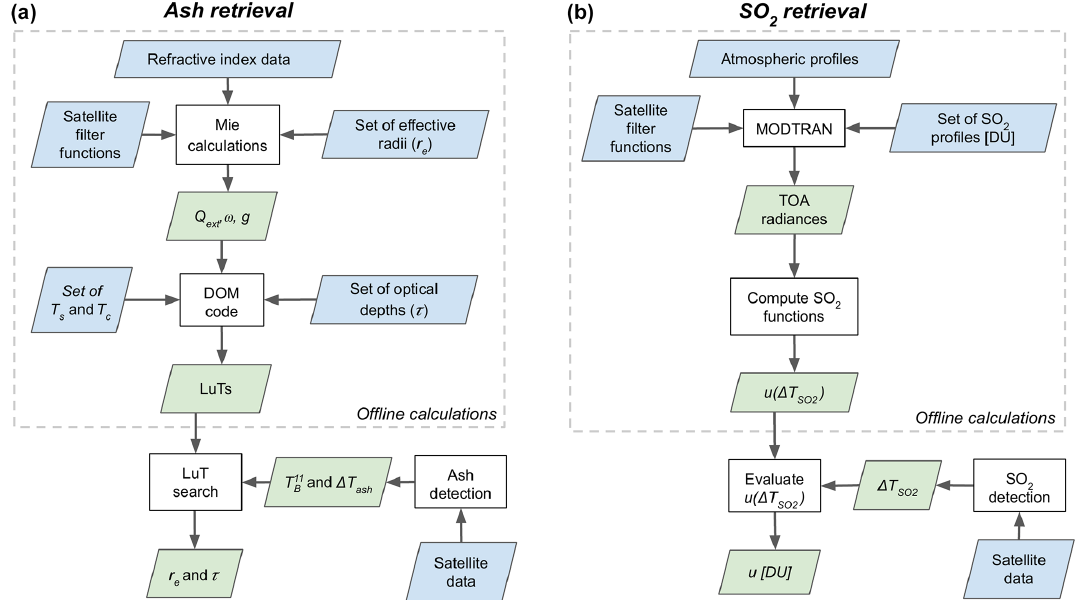
Figure A2. Flow diagram showing the (a) volcanic ash retrieval process and (b) volcanic SO 2 retrieval process used in the present study. Parallelograms indicate datasets (blue for inputs, green for outputs) and rectangles indicate processes (i.e. code used to implement the retrieval algorithms and perform radiative transfer calculations). Offline calculations are any computations that are precomputed (i.e. before any observations are made by the satellite).